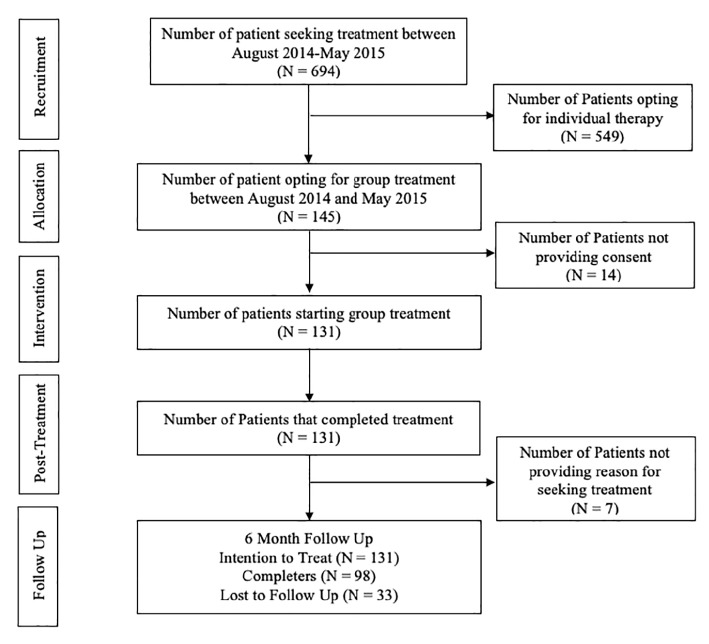
CONSORT diagram.